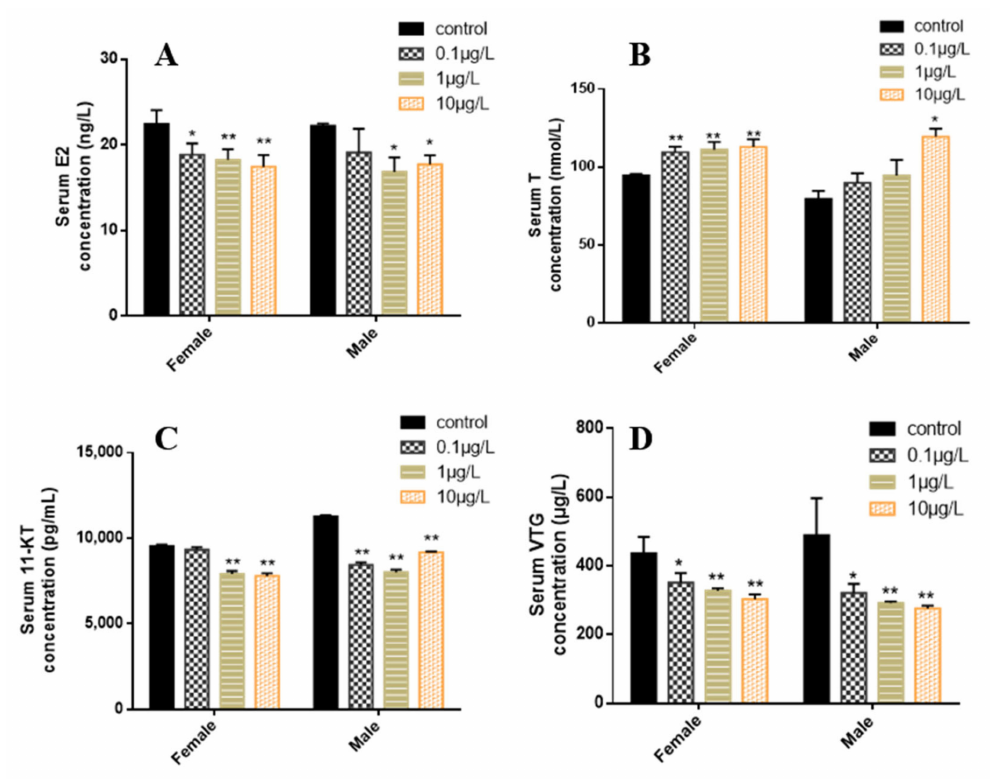
Figure 4. Effects of CyB exposure for 150 d on sex steroid hormones and VTG in F0 zebrafish. ( A ) 17 β -estradiol (E2), ( B ) testosterone (T), ( C ) 11-ketotestosterone (11-KT) and ( D ) vitellogenin. The results are presented as the mean ± SD of three replicates (* p < 0.05; ** p <